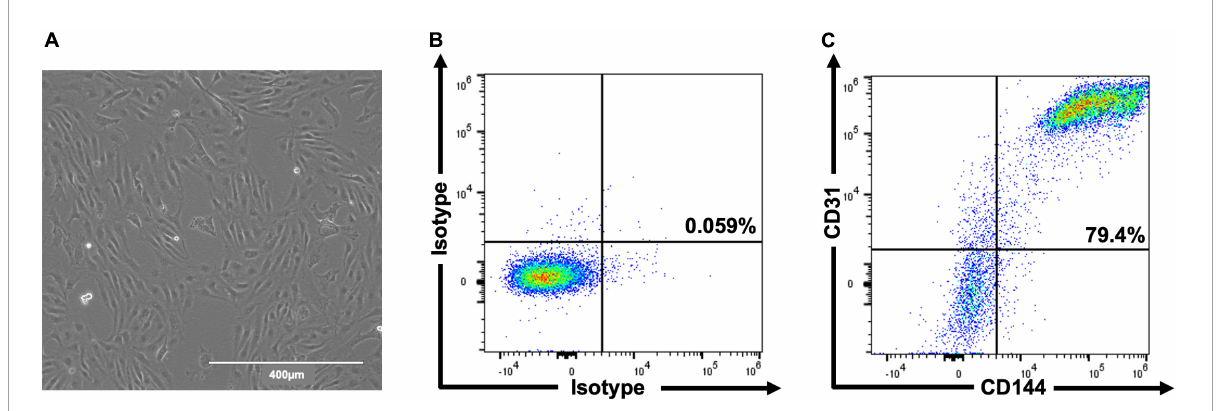
FIGURE2 Representative images of hESC-ECP differentiation and phenotypic characterization. Day 8 morphology and confluency (A) and representative flow cytometric analysis (B,C) of isotype controls and hESC-ECP stained for CD31 (PECAM1) and CD144